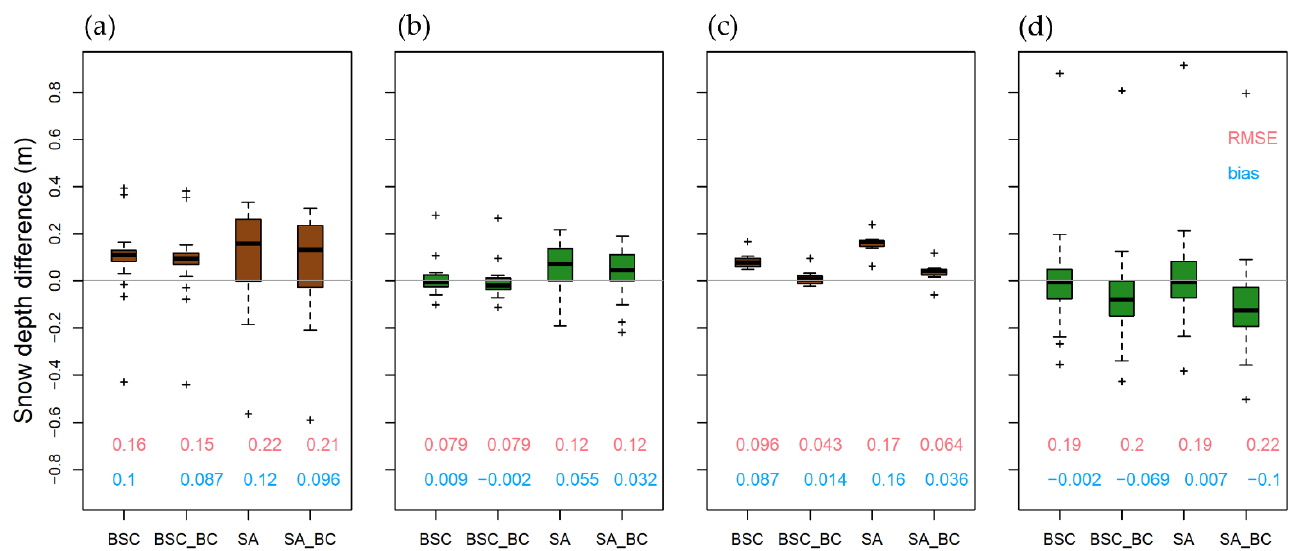
Figure 11. Distribution of the differences between lidar and manual snow depth for the different point cloud processing methods. ( a ) Sainte-Marthe field; ( b ) Sainte-Marthe forest; ( c ) Montmorency field; and ( d ) Montmorency forest. BSC: Boresight calibrated point cloud; SA: Boresight + strip-aligned point cloud; BSC_BC: Bias-corrected BSC data; SA_BC: Bias-corrected SA data. Outliers are indicated by “ + ” symbol in boxplots.